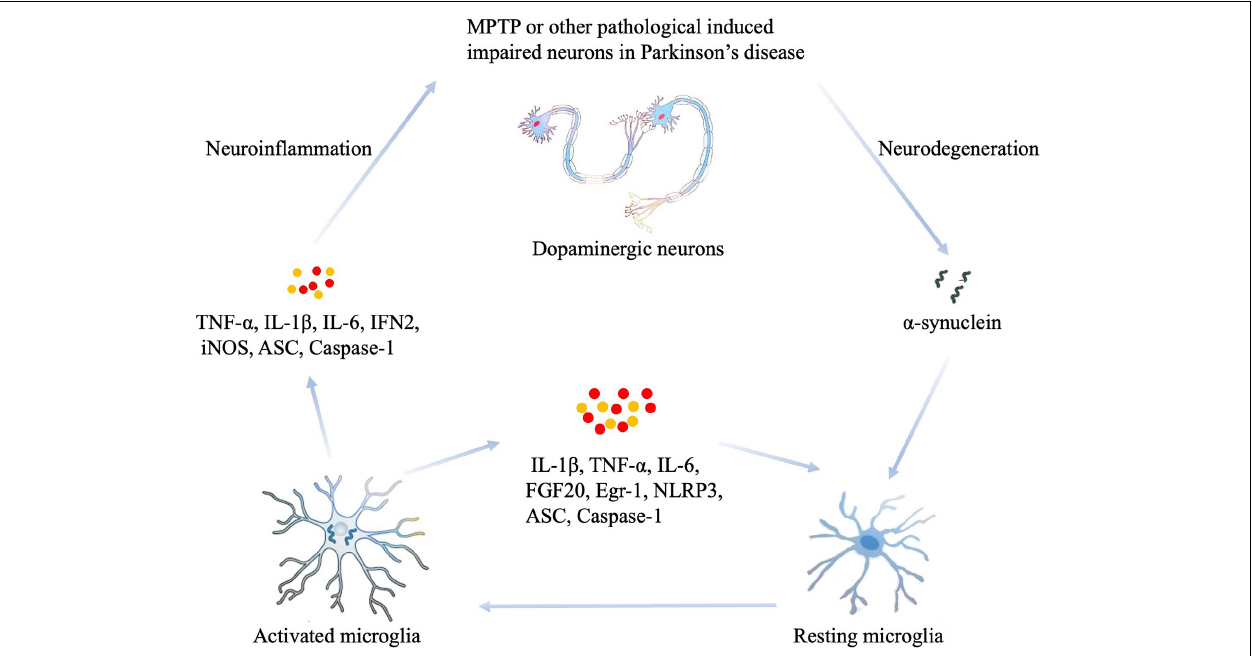
FIGURE 1 | The role of MG in the neuroinflammation that occurs during PD. Damaged or dying neurons in PD, or toxin-induced models such as MPTP, cause the release of impair-associated molecular patterns (IAMPs) and α -synuclein to activate microglia through pattern recognition receptors (PRRs). Thus, the resting states of MG can be activated, thus leading to the eventual release of proinflammatory cytokines, including IL-1 β , IL-6, TNF- α , and other inflammatory mediators such as ASC, IFN2, iNOS, and Caspase-1. In addition, increased levels of proinflammatory cytokines activate other resting MG, which induces neuroinflammation or neurodegeneration in the damaged area. MPTP, 1-methyl-4-phenyl-1,2,3,6-tetrahydropyridine; IL-1 β , interleukin-1 β ; IL-6, interleukin-6; IFN2, type 2 interferon; iNOS, inducible NOS; TNF- α , tumor necrosis factor- α ; ASC, apoptosis-associated speck-like protein containing a